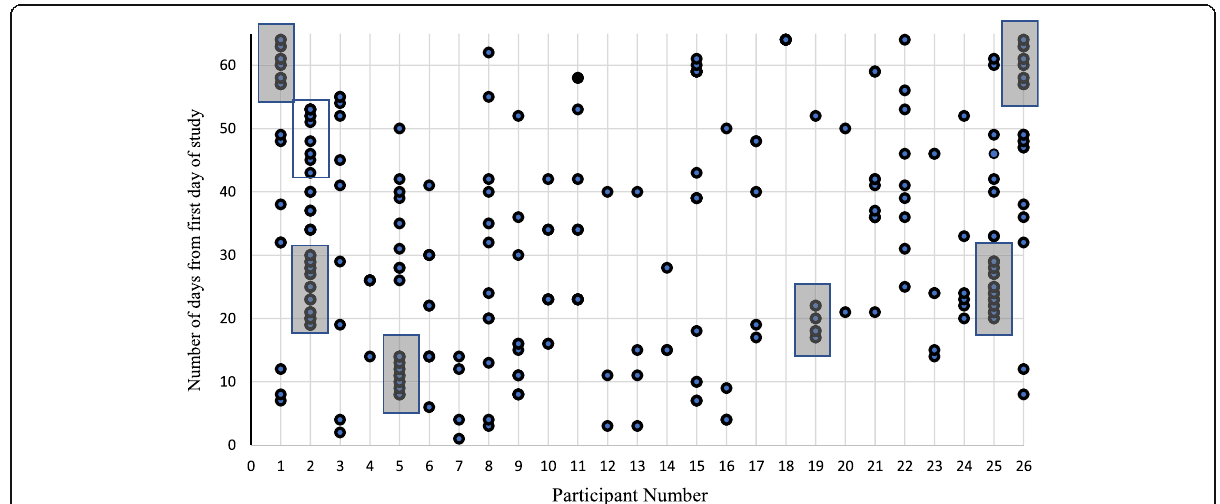
Fig. 1 Check-in rates for each participant. Shaded boxes indicate topical runs (check-ins shared topics) and unshaded boxes indicate runs (check- ins that did not share